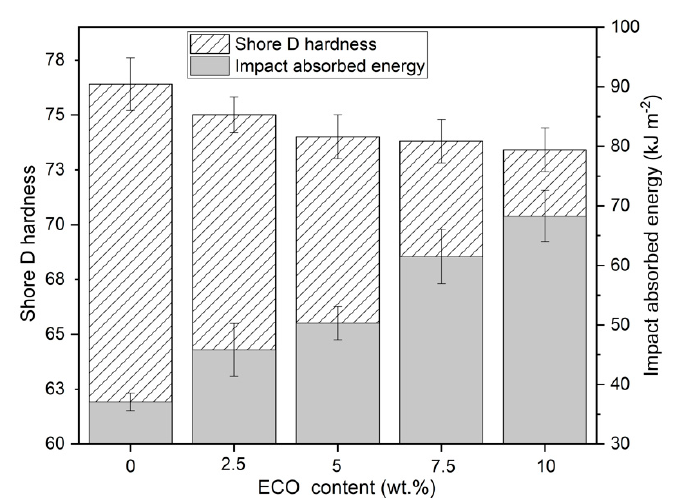
Figure 4. Plot evolution of Shore D hardness and impact absorbed energy of PLA with different epoxidized chia seed oil (ECO) content.